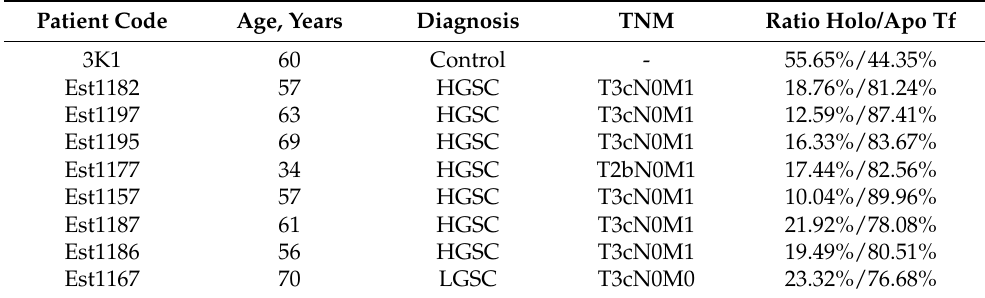
Table 6. The serum ratio of holo-transferrin to apo-transferrin in the study group and the control group, as determined by immunoaffinity chromatography.